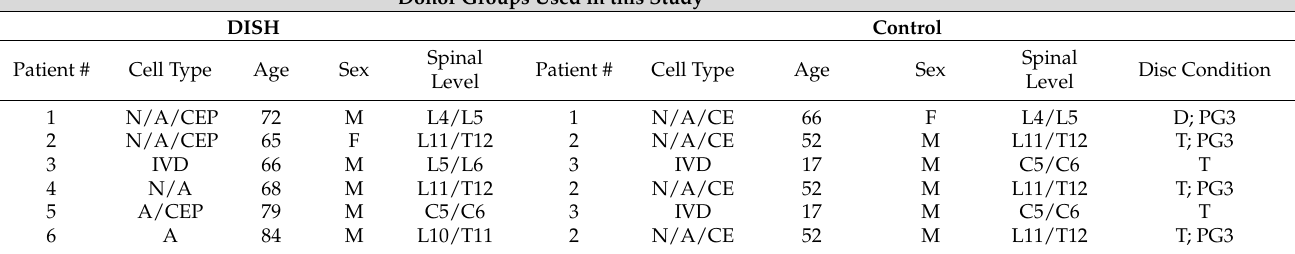
Table 1. Donor list of intervertebral disc cells. Cell type:nucleus pulposus (N), annulus fibrosus (A), cartilaginous endplate (CEP), C = cervical, L = lumbar, intervertebral disc mixed (IVD) Sex: Female (F), Male (M). Disc condition: Degenerated (D), Trauma (T), Pfirrmann Grade (PG).